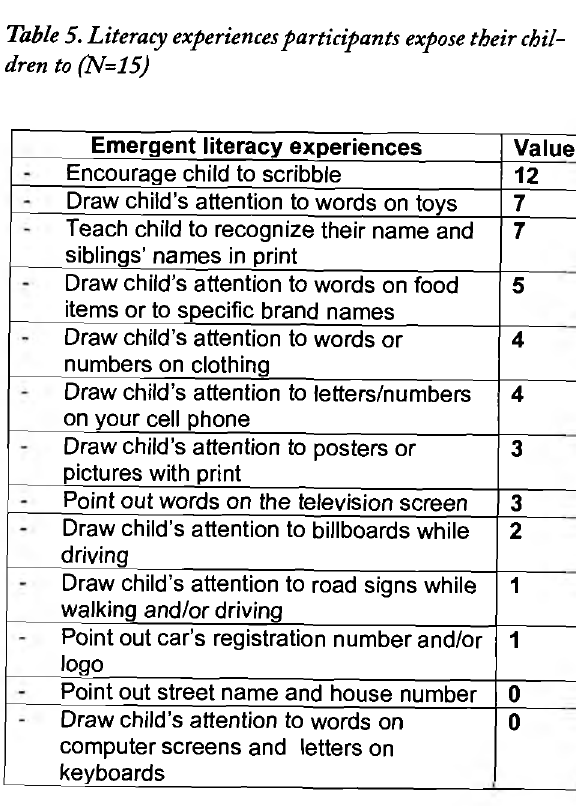
Table 4. Criteria participants use to select reading material Table 5. Literacy experiences participants expose their